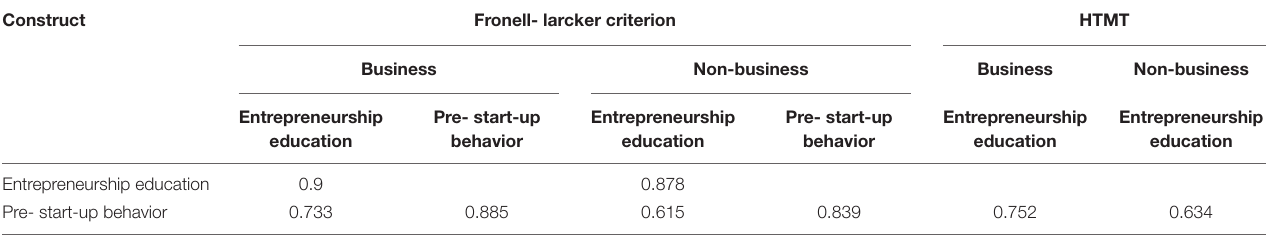
TABLE 8 | Discriminant validity (Split dataset).